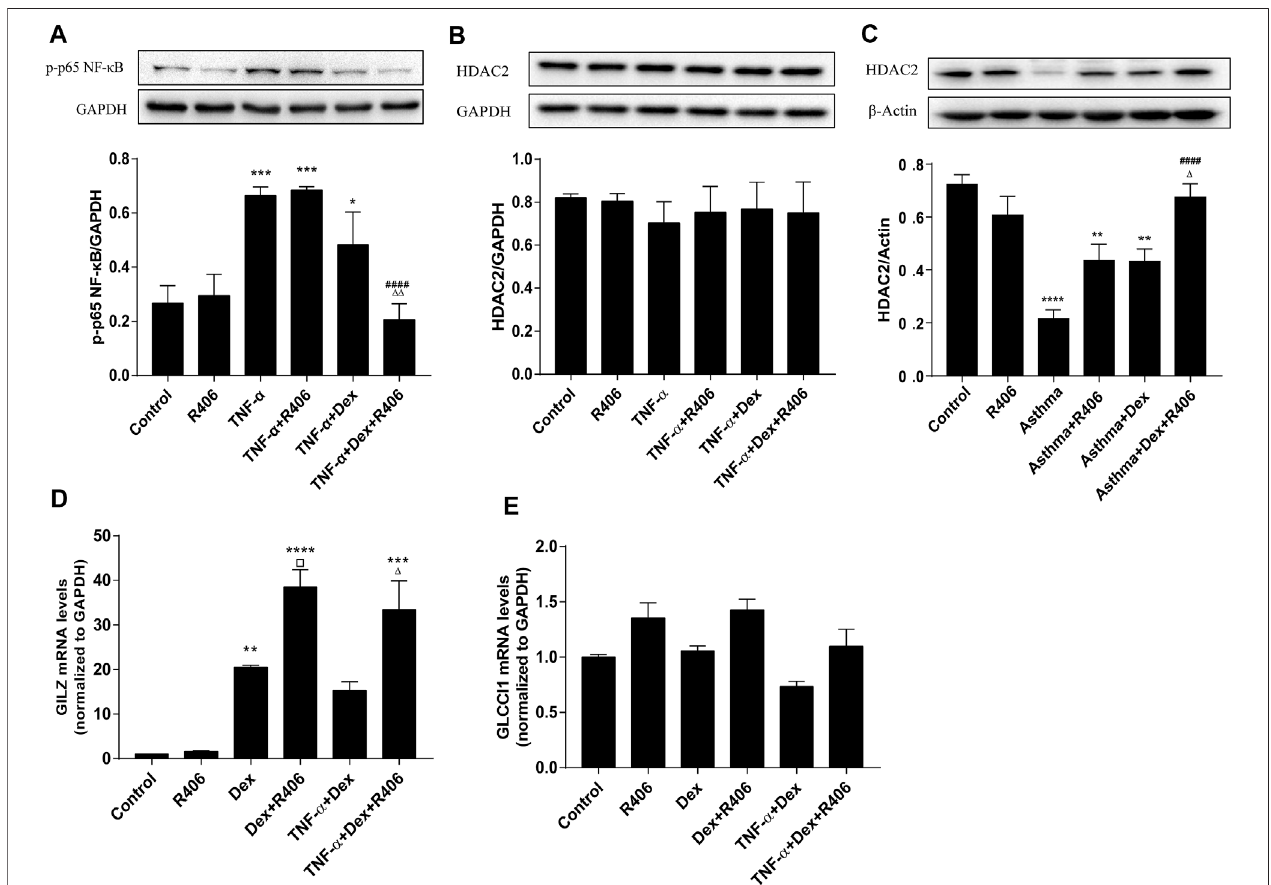
FIGURE 6 | The Syk inhibitor R406 enhances the inhibitory effect of dexamethasone on transrepression and transactivation. (A) BEAS-2B cells were pretreated withR406(1 μ M)for30 min,incubatedwithorwithoutDex(1 μ M)for2 h,andstimulatedwithTNF- α (10 ng/ml)for10 min (B) BEAS-2BcellswerepretreatedwithR406 (1 μ M) for 30 min and incubated with TNF- α (10 ng/ml) or with Dex (1 μ M) and TNF- α for 12 h. (C) The expression of HDAC2 in asthmatic mouse lung tissues was determined by Western blotting. n = 5/group. (D,E) BEAS-2B cells were pretreated with R406 (1 μ M) for 30 min, incubated with Dex (1 μ M) for 2 h and stimulated with or without TNF- α (10 ng/ml) for 24 h, and the mRNA levels of GILZ and CLCCI1 were measured by PCR. n = 3/group, * p < 0.05, ** p < 0.01, *** p < 0.001, **** p < 0.0001,compared withthecontrolgroup; ## p < 0.01, #### p < 0.0001,compared withtheTNF- α orasthmamodel group; ▫ p < 0.05comparedwiththeDexgroup; △ p < 0.05, △△ p < 0.01, compared with the TNF- α +Dex group or asthma + Dex treatment